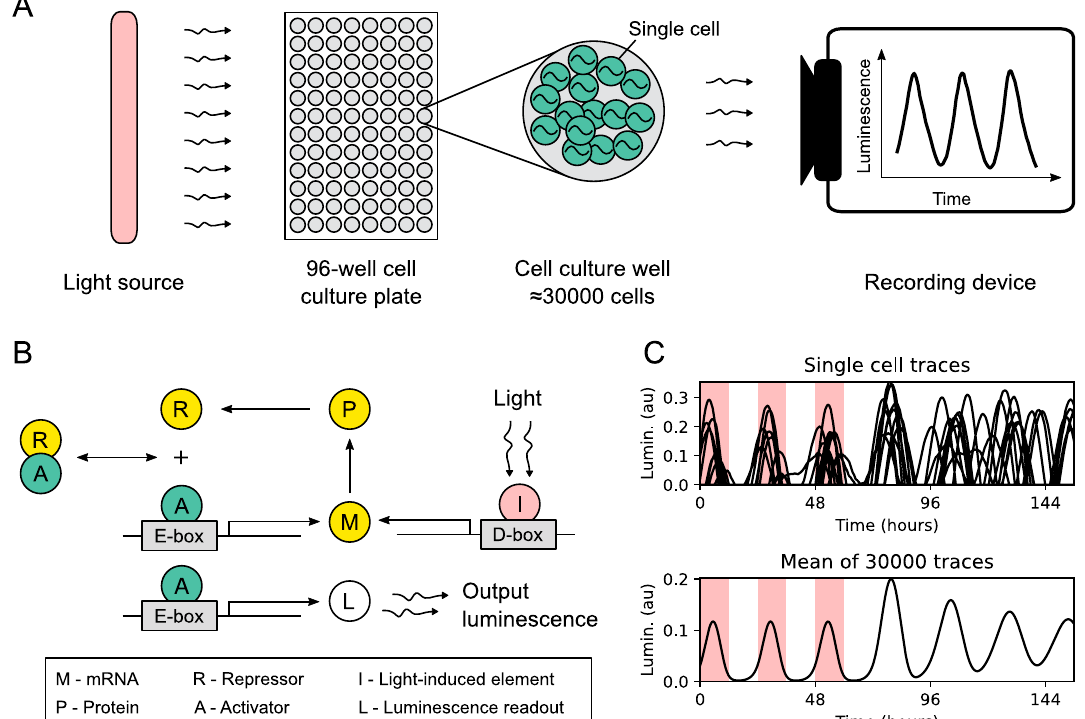
Figure 1. Experiment setup and simulation of core circadian clock dynamics in zebrafish cell cultures. ( A ) 96-well culture plates were placed in a dark room and illuminated with a time-controlled light source. Each well contains approximately 30,000 cells transfected with a bioluminescent reporter of zper1b transcription. The output luminescence from each well is recorded as a separate time trace. ( B ) Schematic of the mathematical model of the zebrafish core circadian clock. The activator (green) binds to the E-box enhancer in the promoter of a clock gene and activates the production of the repressor (yellow). After transcription, translation, and translocation back to the nucleus, the repressor binds to the activator, thus preventing E-box-driven transcriptional activation. External light stimuli take effect through the activation of a light-driven gene with the D-box enhancer. The luminescence output is assumed to be proportional to the E-box activation. ( C ) Simulated luminescence traces are obtained by averaging 30,000 independent evaluations of the model. The output luminescence after normalization is presented in arbitrary units (au). Red shading indicates periods when the light source was turned